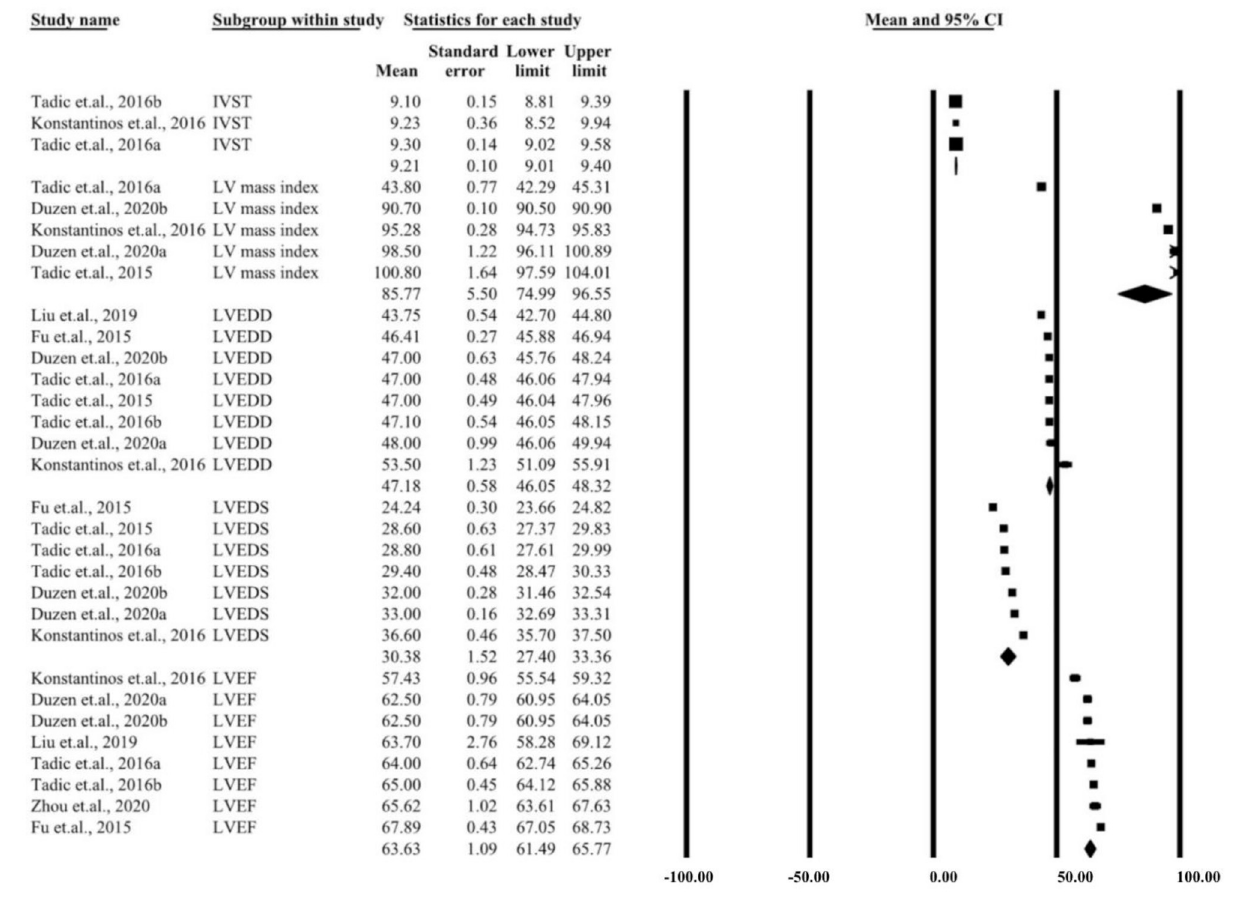
Frontiers in Cardiovascular Medicine |